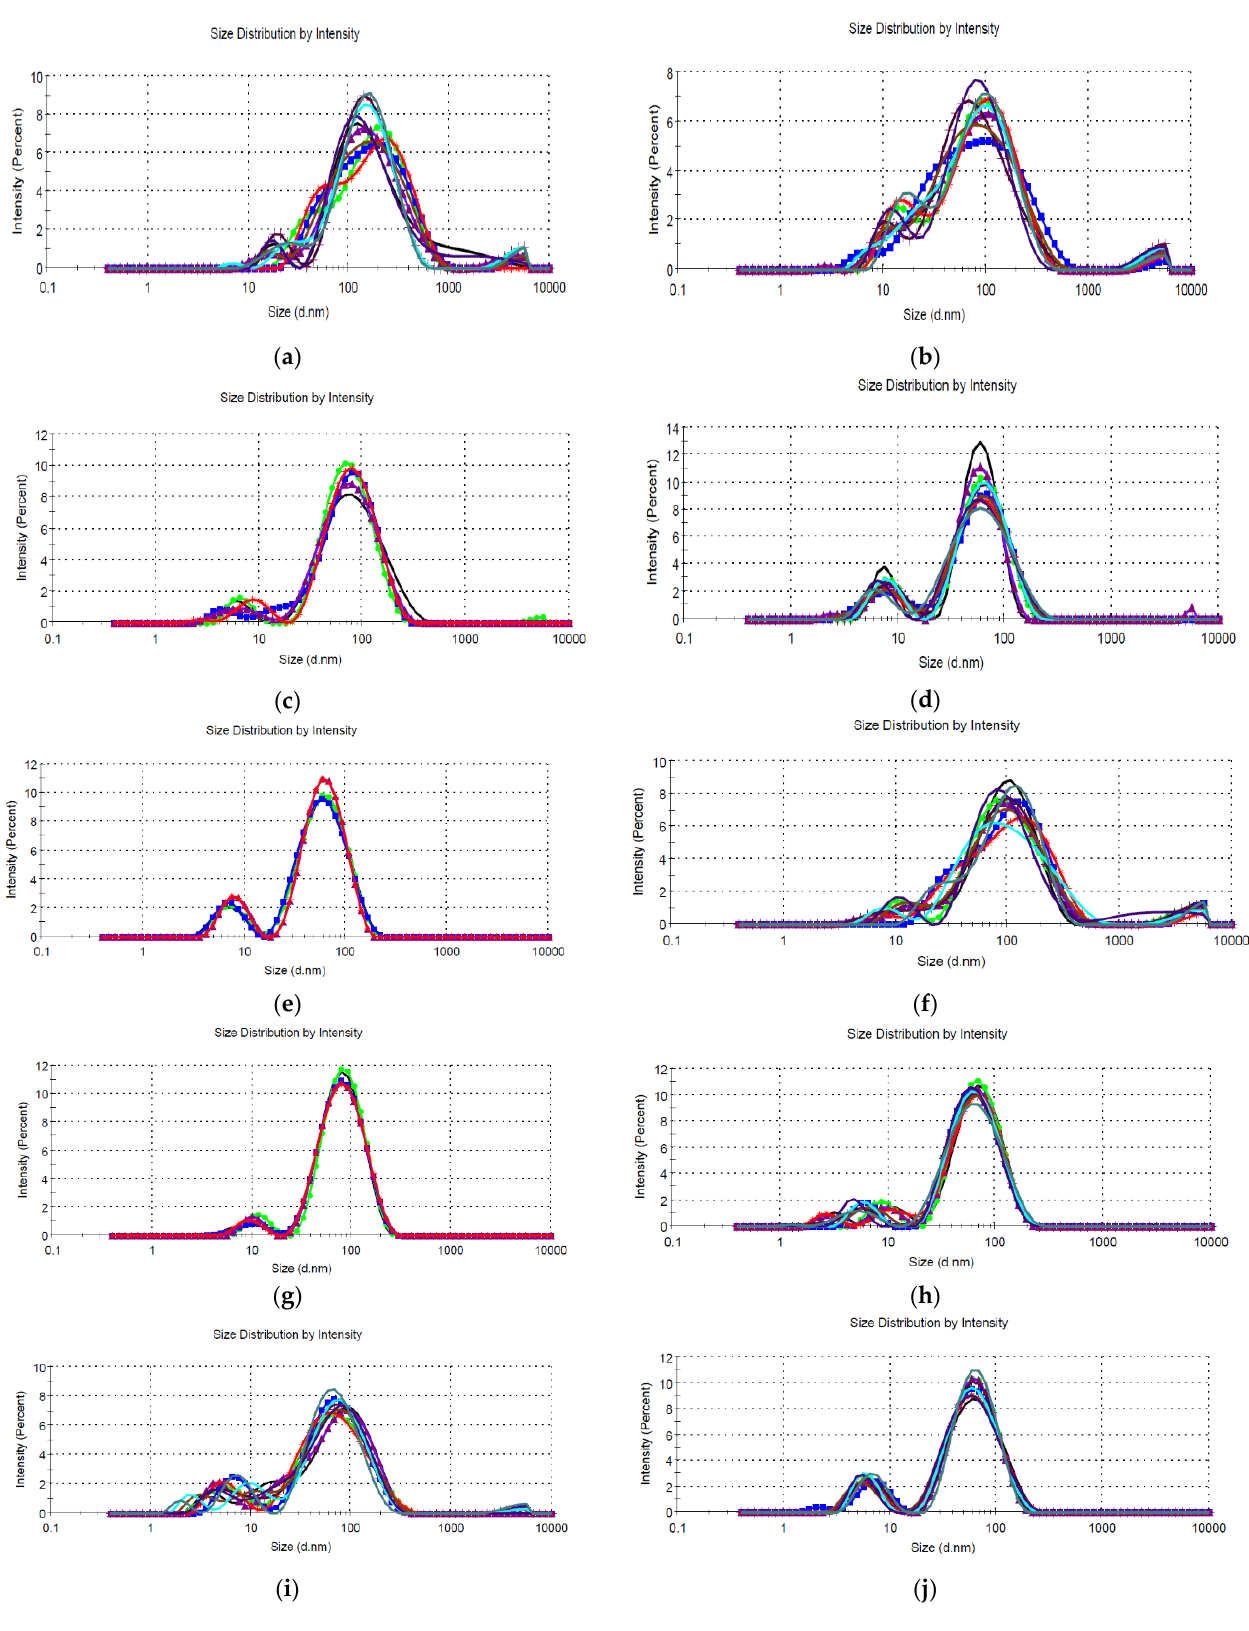
Figure 4. Size distribution by intensity, determined via the DLS technique, for ( a ) sample EM5; ( b ) sample EM2.5; ( c ) sample EM2; ( d ) sample EM1.25; ( e ) sample EM1; ( f ) sample EE5; ( g ) sample EE2.5; ( h ) sample EE2; ( i ) sample EE1.25; and ( j ) sample EE1.